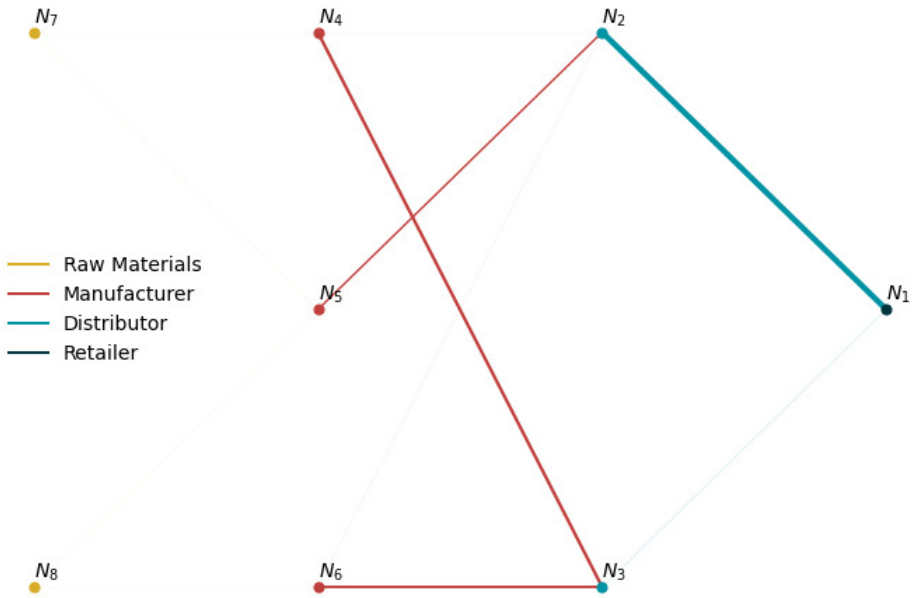
Figure 7. Average network flow with the RL policy (lost sales mode). Total flow is proportional to the edge